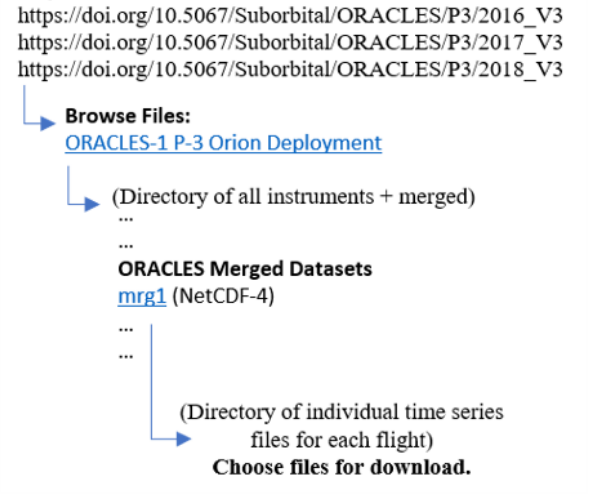
Figure 13. Schematic showing user navigation from the DOI home pages to the merged time series files (containing WISPER data along with other ORACLES